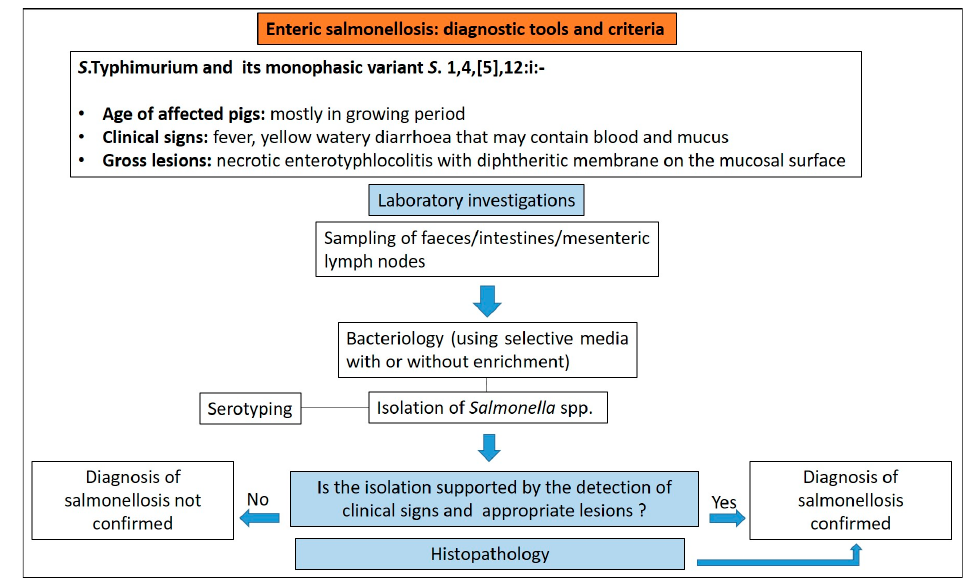
Figure 19. Diagnostic algorithm for the diagnosis of salmonellosis in